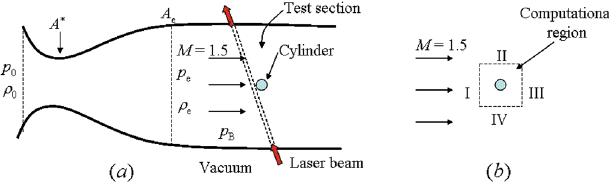
FIG. 1. (a) Schematic diagram of a supersonic nozzle and a cylinder inserted laterally into the supersonic flow to generate a detached shock. (b) Computational region of the gas